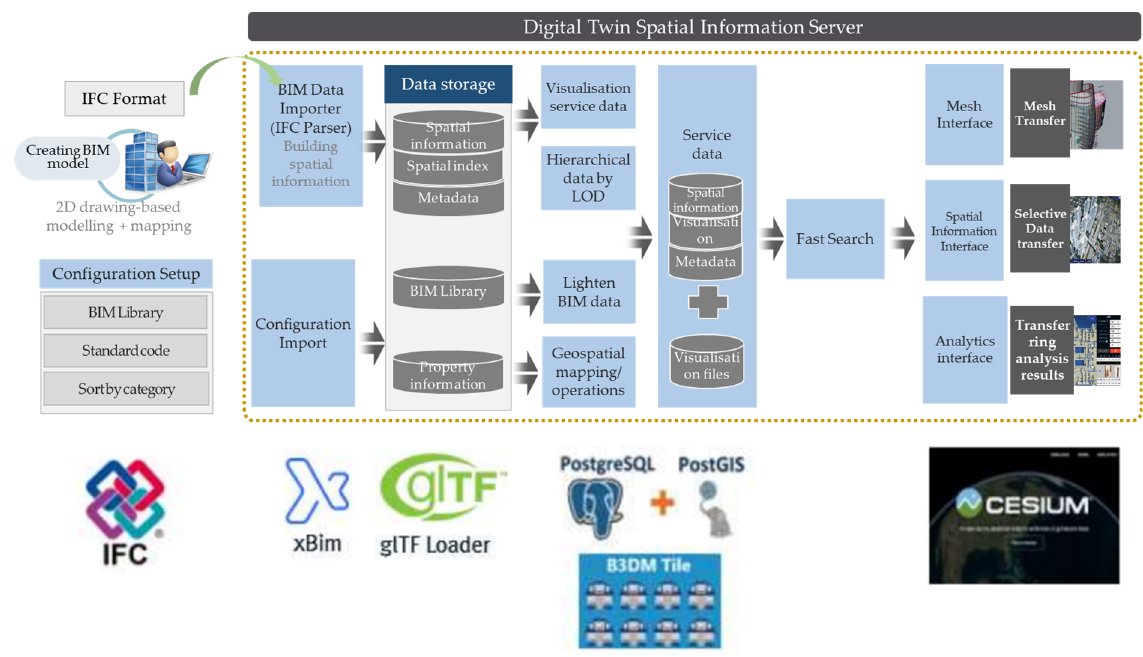
Figure 8. Service flow of a digital twin space.